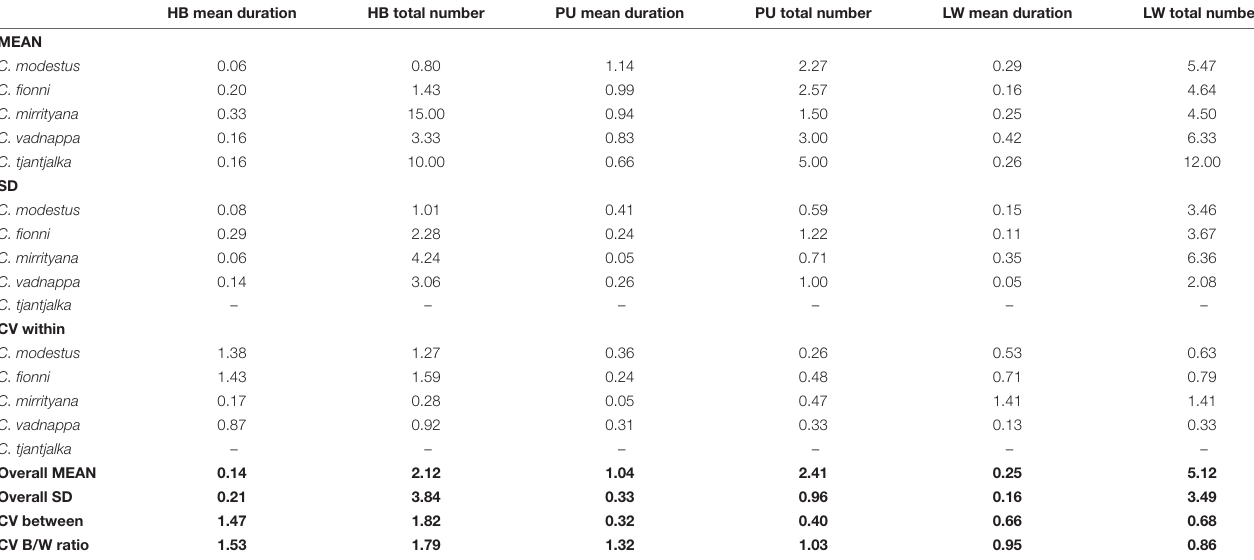
TABLE 2 | Coefficients of variation calculated within and between species for mean duration and total number of motor pattern events (HB, head bobs; PU, push ups; LW, limb waves).